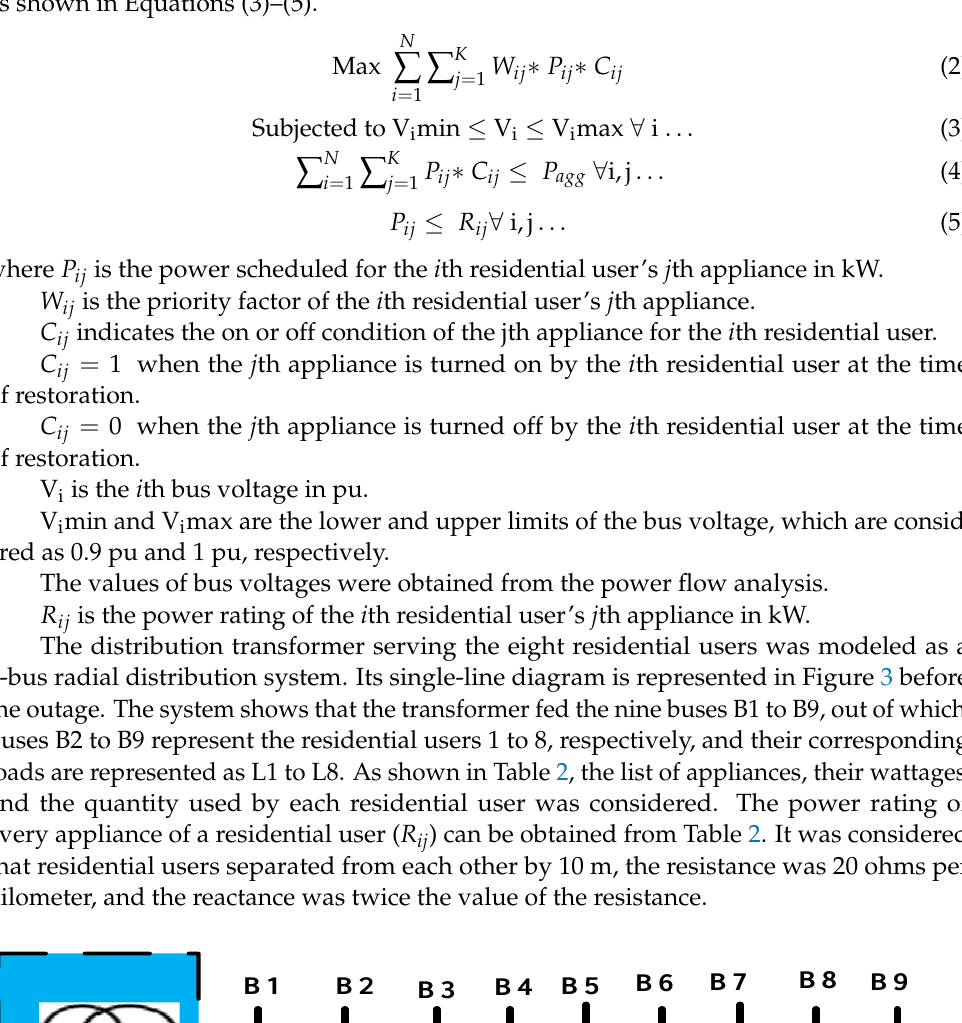
Figure 4. Single-line diagram of the radial distribution system at the time of restoration. Later, Newton ’ s method of power flow was implemented in the test system to iden- tifythe voltage violations in the MATLAB/MATPOWER environment. If no violations were found, appliances were powered per their requirements. If violations existed, then prioritization of appliances was required. Every appliance in all residences was indexed and their corresponding weight factors were assigned according to the individual resi- dential user priorities. The sum of the weight factors assigned to connected appliances of every residential user must be equal to 1. Figure 5 shows the flowchart of the method- ology to follow for implementing priority-based scheduling of the appliances using EVs in this study. If the voltage magnitudes were within the limits, it implied that the power available from EVs was more abundant than the actual load. Otherwise, load shedding was made equivalent to the difference between the available EVs ’ power and the actual residential need for power at the time of restoration. Thereby, the load shedding ensured that the bus voltages were within the limits and the objective function was calculated, which gave the schedule for maximum energy restored to the appliances according to their weight priority factors for every residence by using LINGO optimization modeling.